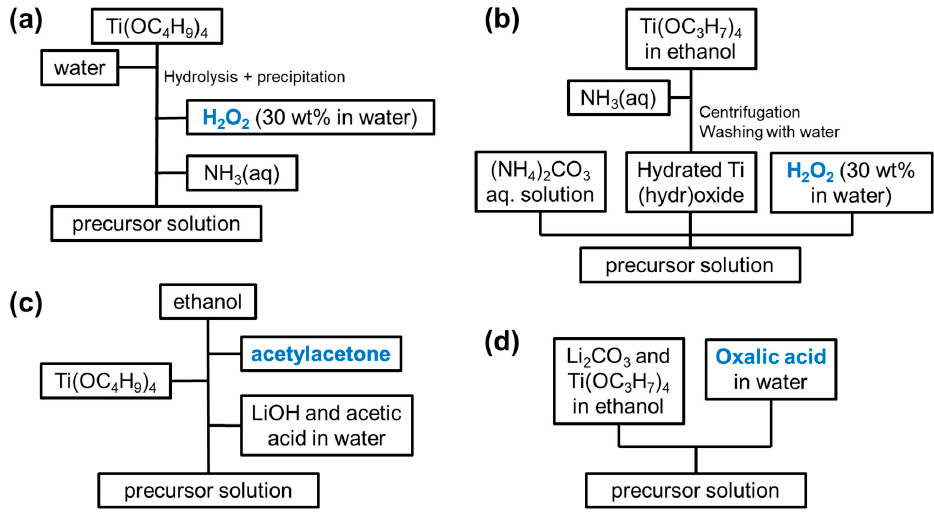
Figure 4. Procedures to prepare an aqueous solution starting from titanium alkoxide, as proposed by ( a ) [222,249]; ( b ) [127]; ( c ) [229,238]; ( d )